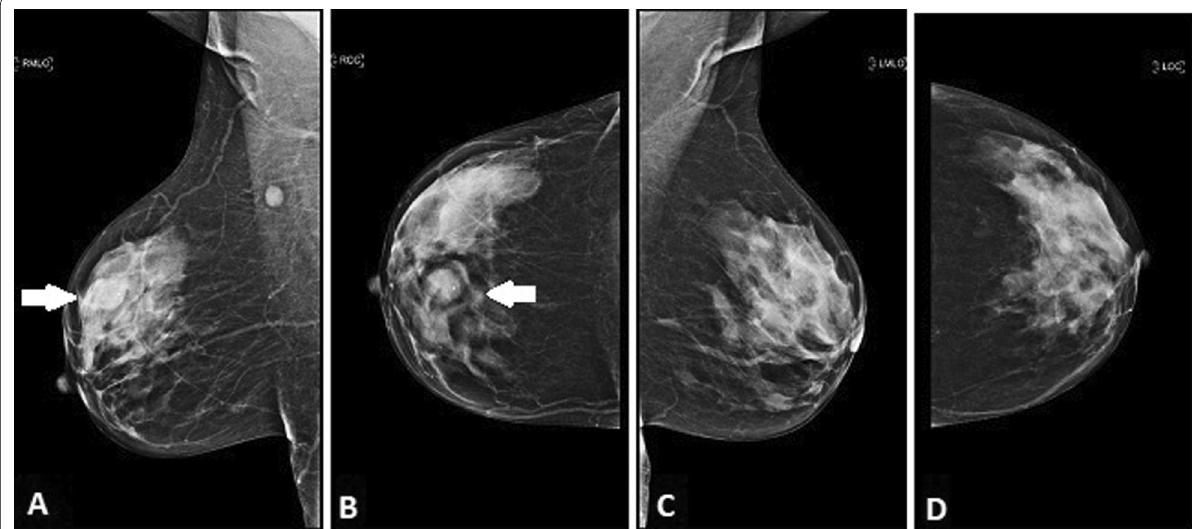
Fig. 2 Mammogram images of same female a , b MLO and CC views of right breast showing heterogeneously dense breast parenchyma with a rounded high-density having indistinct and party obscured margins in upper central location (white arrow), c , d MLO and CC views of left breast showing heterogeneously dense breast